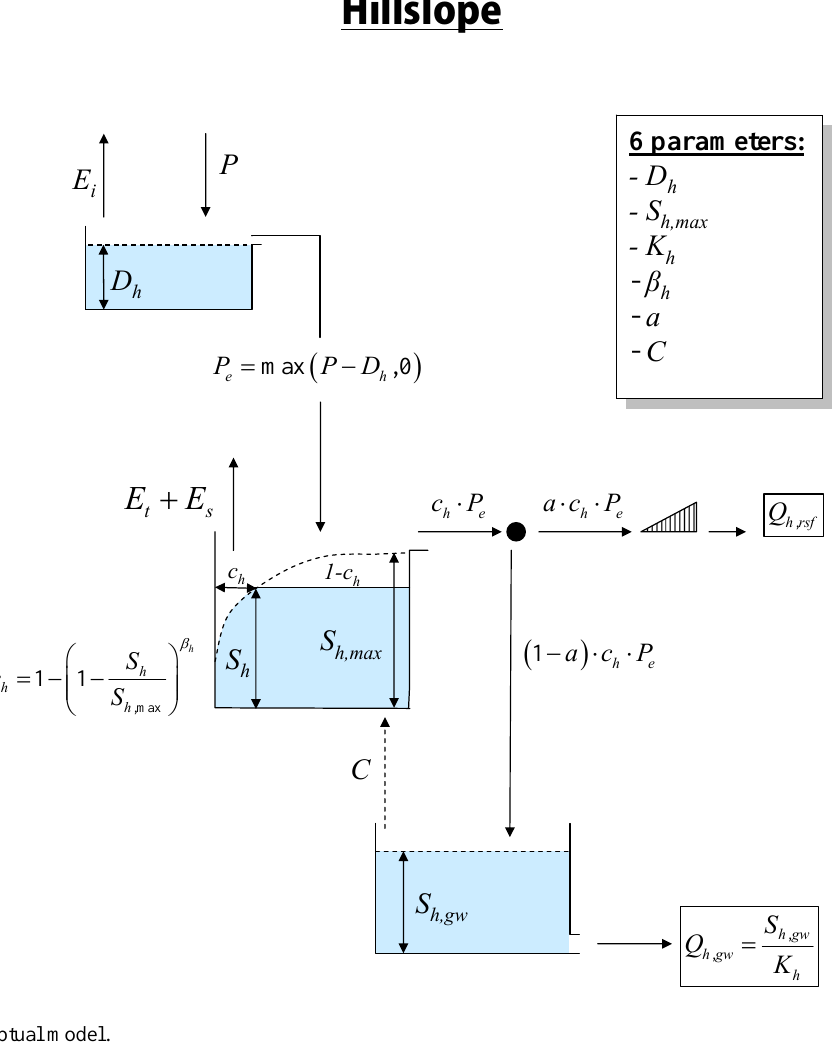
Fig. 3. Hill slope conceptual